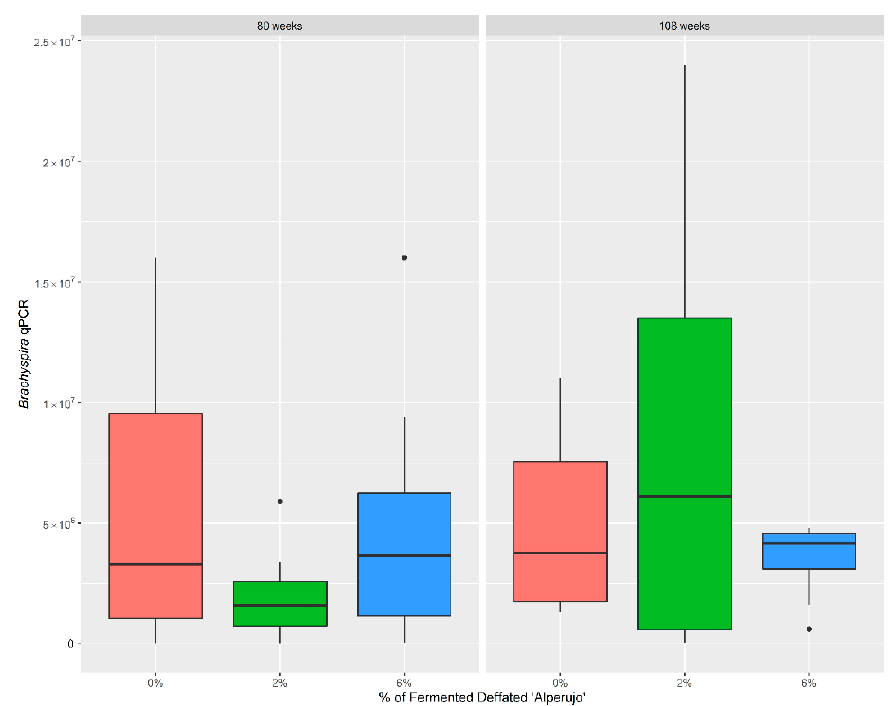
Figure 1. Distribution of the Brachyspira spp. qPCR (genome equivalent/g) observed among groups. Boxes indicate the interquartile range, middle highlighted bars inside boxes indicate median values, and top and bottom of the box indicate the 75th and 25th percentile. Whiskers denote 97.5th and 2.5th percentile. Dots represent outliers. Dietary supplementation with fermented defatted ‘alperujo’ showed a reduction in the cecal Brachyspira content in 80-week-old laying hens.